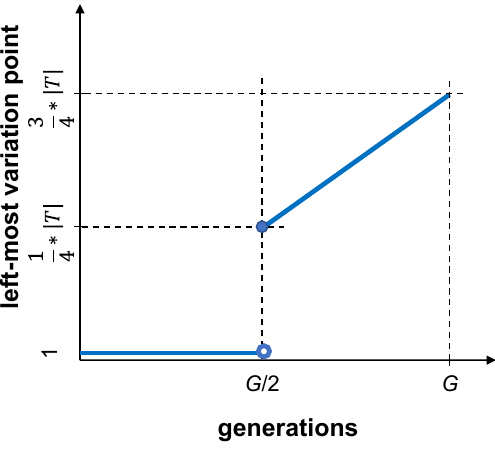
Figure 3. Cooling